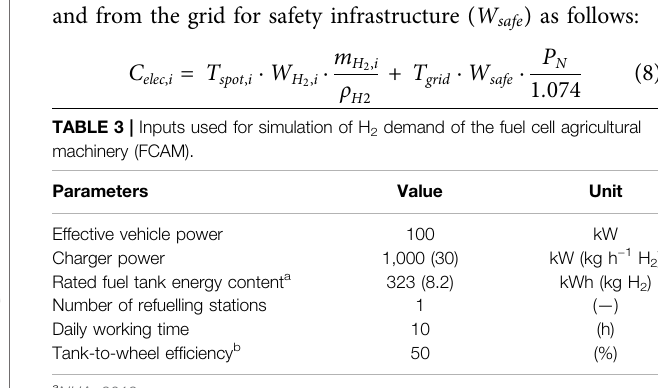
Frontiers in Energy Research |